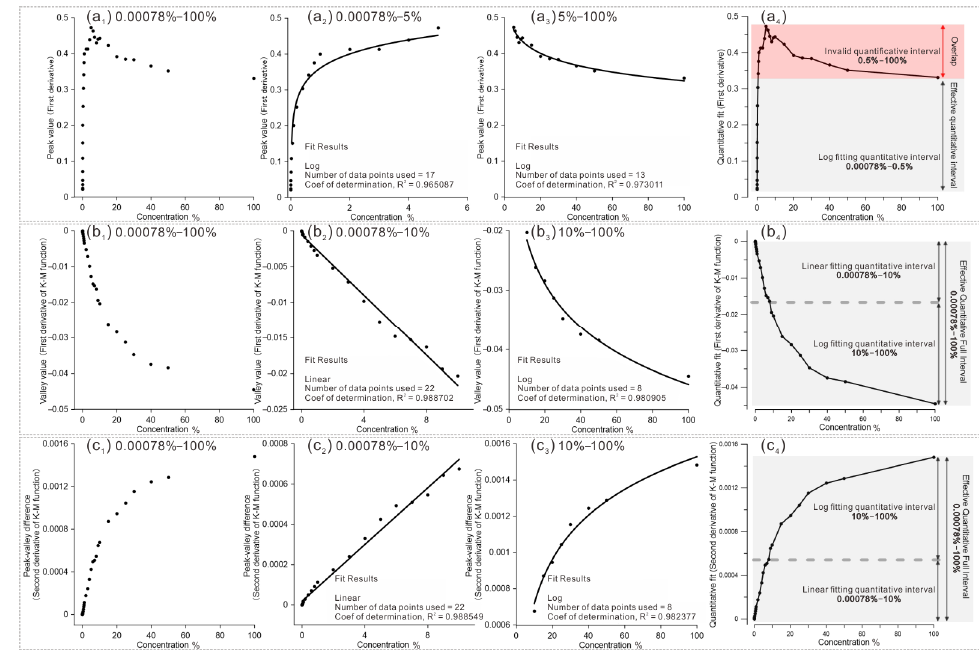
Figure 7. Correlation analysis between DRS proxy and hematite concentration: ( a 1 – a 4 ) the first derivative, ( b 1 – b 4 ) the first derivative of the K–M function, and ( c 1 – c 4 ) the second derivative of the K–M function.